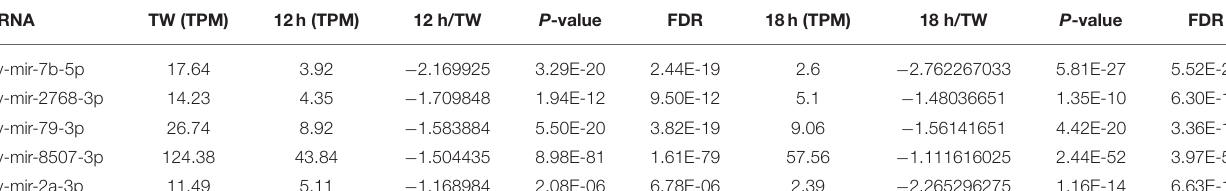
TABLE 3 | Five common differentially expressed miRNAs at 12 and 18h compared to Tween (TW) in Plutella xylostella . miRNA